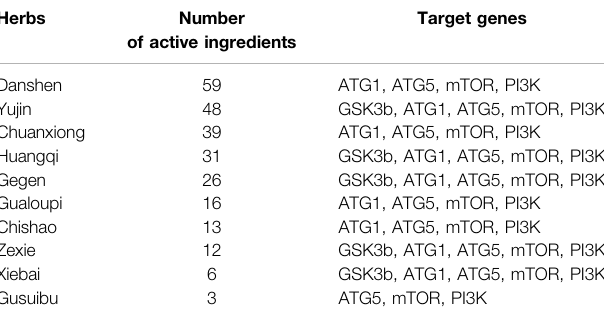
TABLE 2 | The number of active ingredients in herbs of DLTs and their main autophagy-related targets.